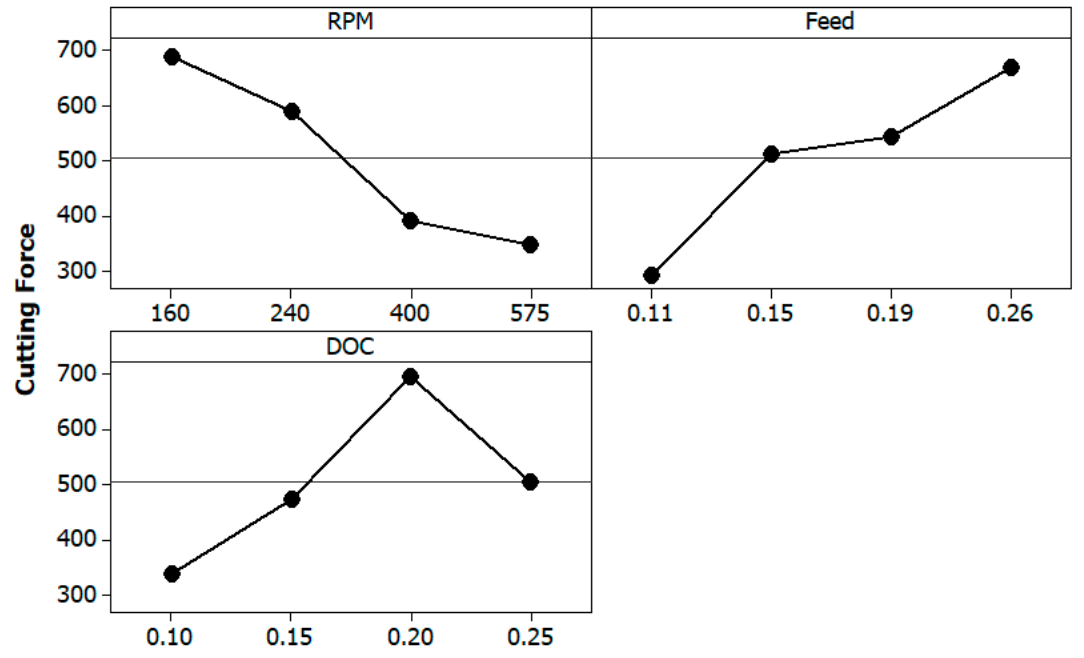
Figure 5. E ff ects of turning parameters on Cutting Force (Fc). Figure 5. Effects of turning parameters on Cutting Force (Fc). Figure 5. Effects of turning parameters on Cutting Force (Fc).